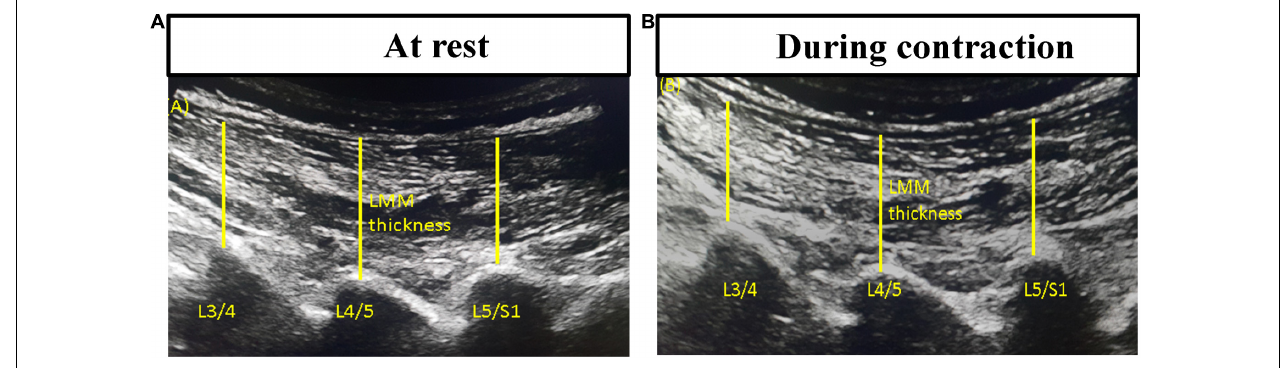
FIGURE 1 | Thickness measurements of lumbar multifidus muscles using bright-mode ultrasound images (A) at rest and (B) during contraction.